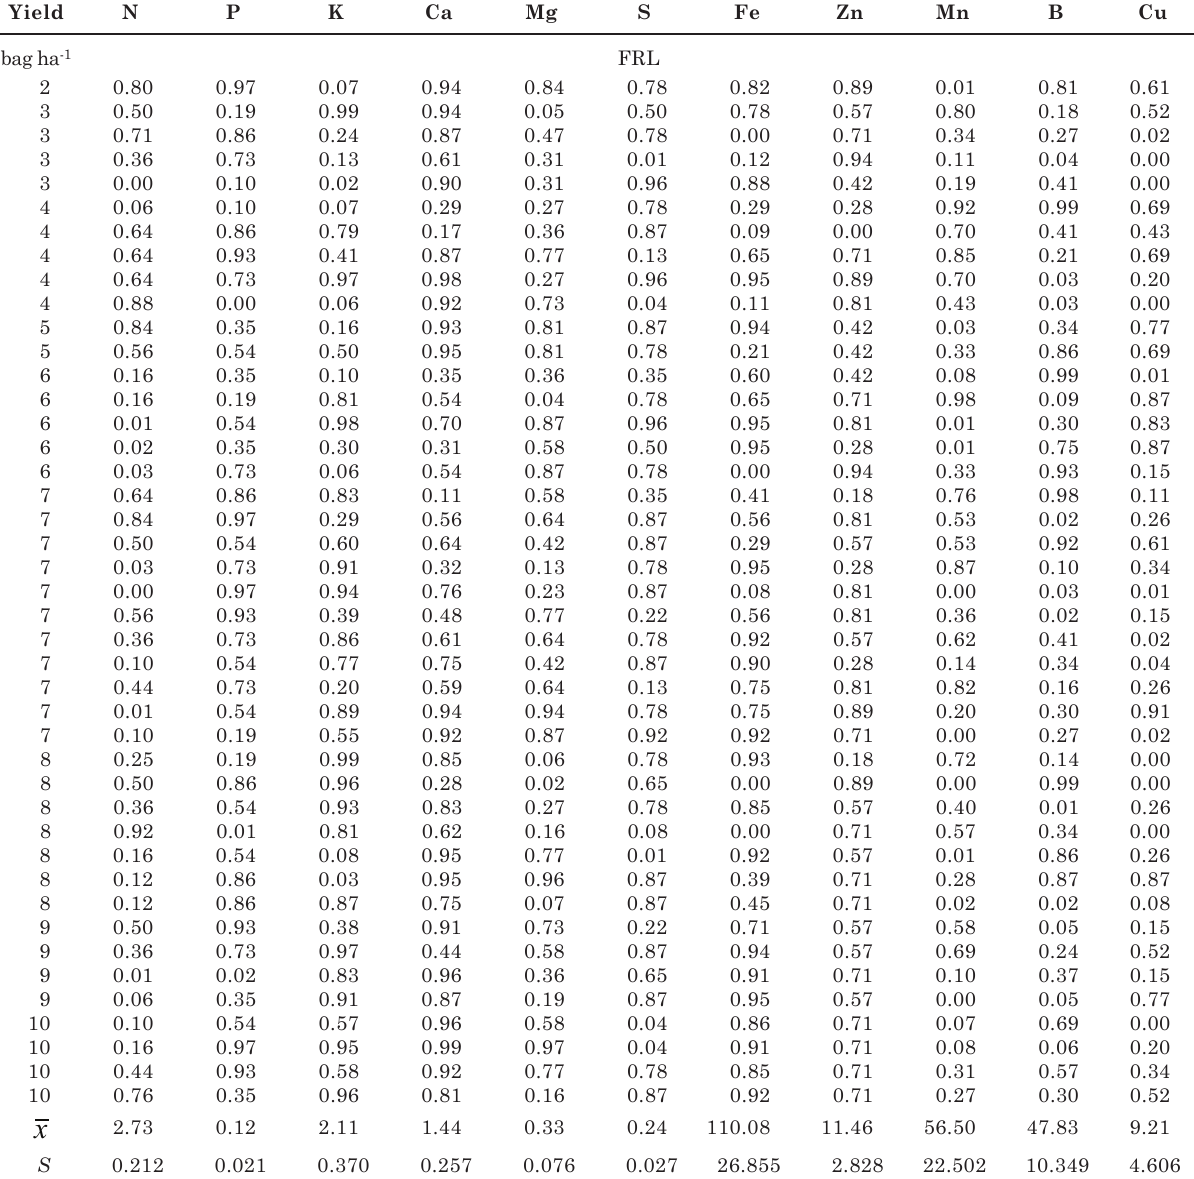
table 2. Fertilization response likelihood ( FRL ) for coffee yields up to 10 bags ha -1 and reference standards using the mean ( x ) and standard deviation ( s ) of nutrients in the high yield group (> 30 bags ha -1 )